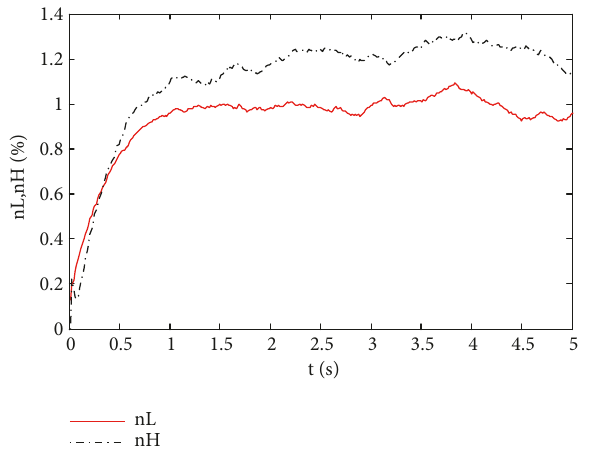
Figure 7: Step response results under control ( T =0.008s, P =2).